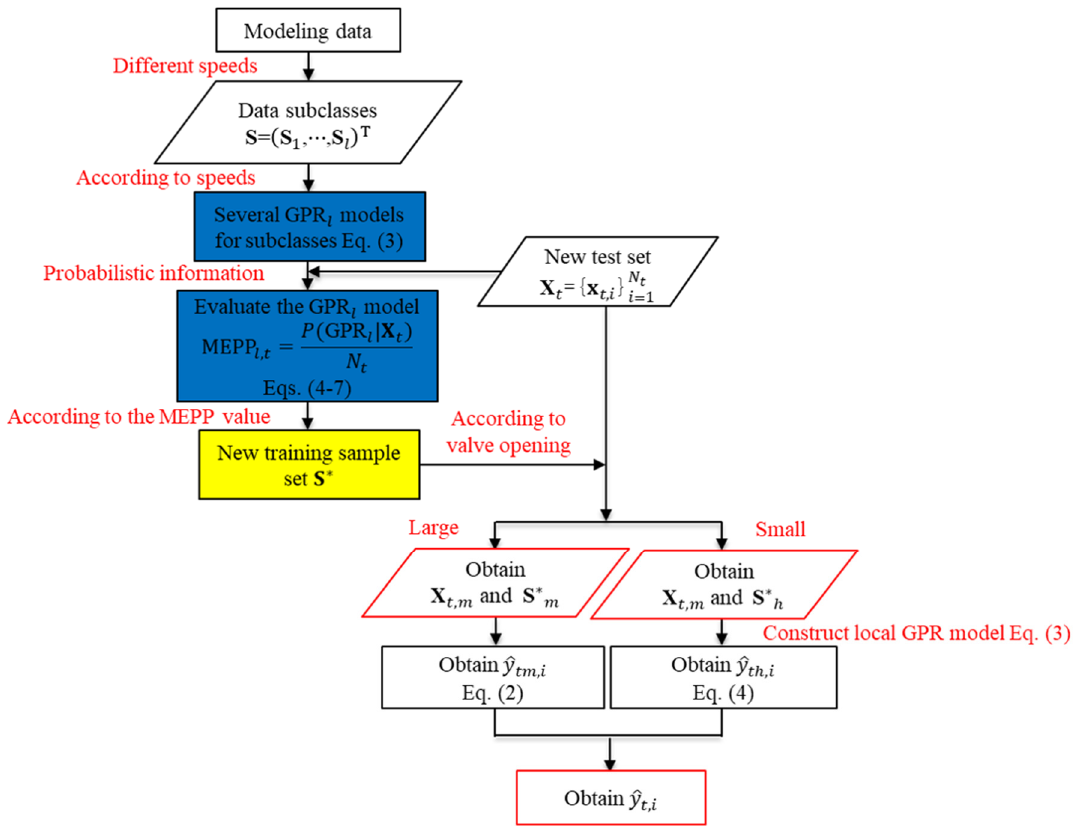
Figure 6. Modeling flowchart for the efficiency prediction of centrifugal pump at different rotational speeds.